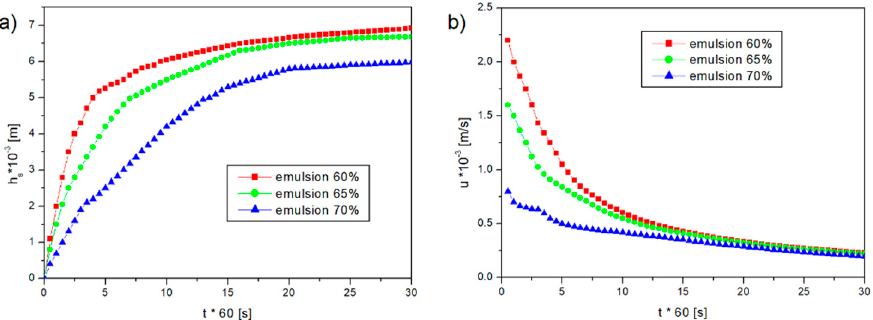
Figure 9. Dependence of ( a ) sediment layer height and ( b ) sedimentation velocity versus process time for sedimentation of 0.2 g/mL microspheres in the size range of 300–400 μ m in emulsions with different concentrations, d e1 .